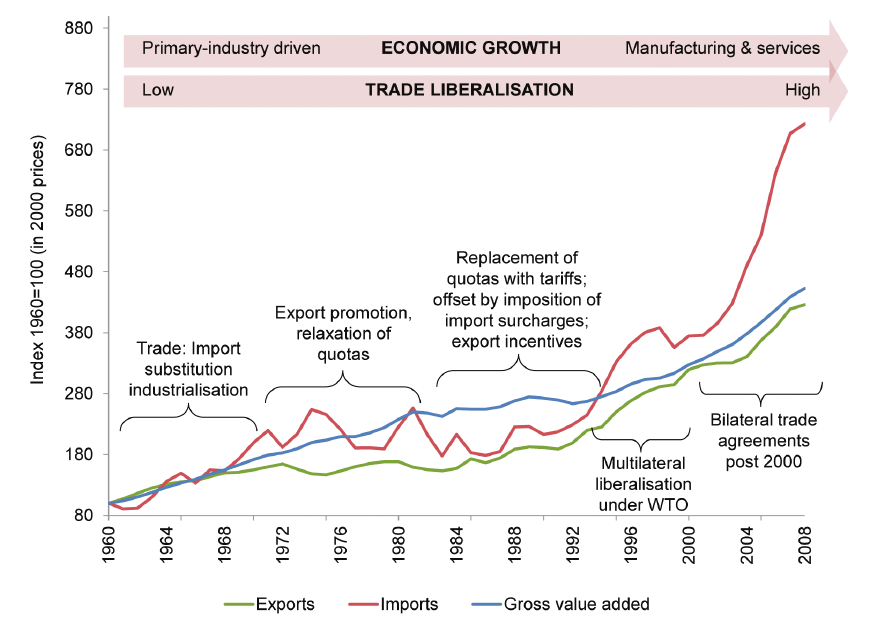
Figure 2: South Africa’s GDP, export and import growth since 1960 compared with shifts